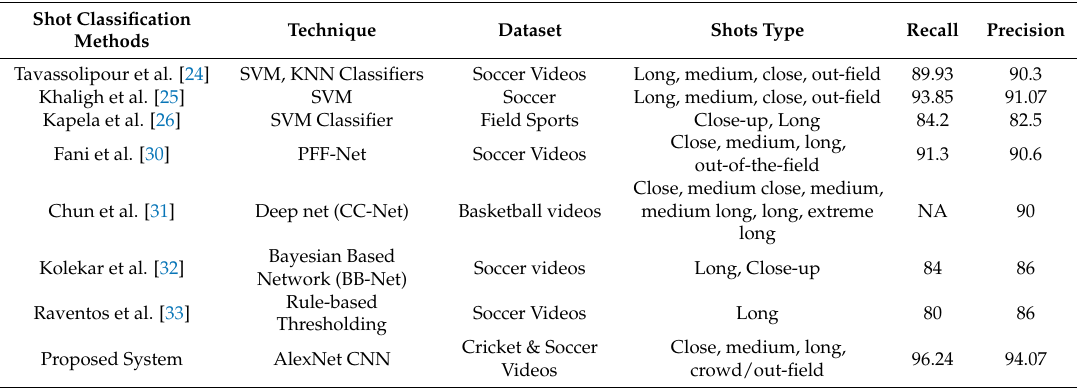
Table 11. Performance comparison with existing shot classification